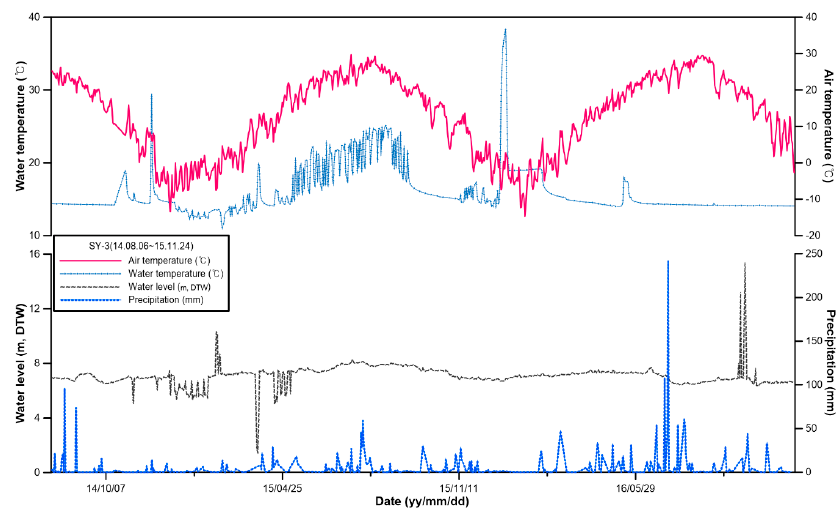
Figure 5. Air temperature, precipitation, water level, and water temperature measured at the study site from August 13, 2014, to November 24, 2016.